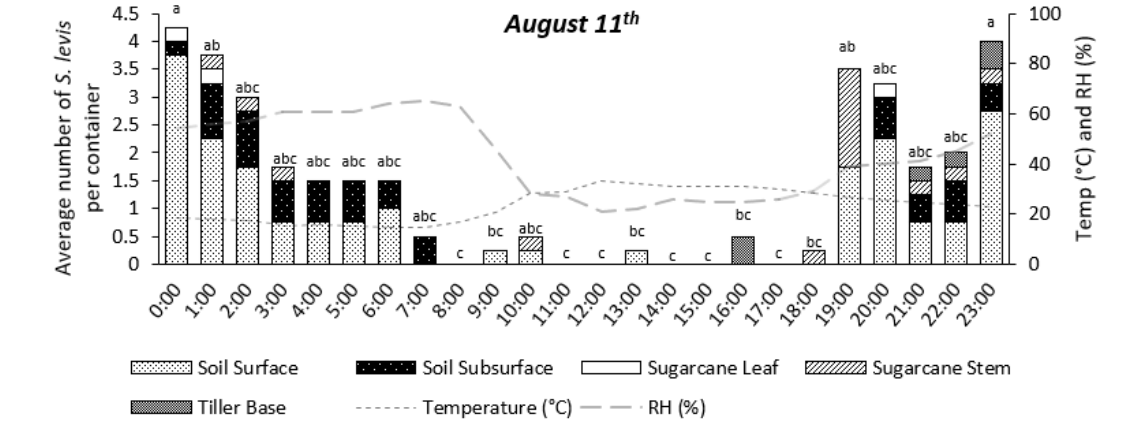
Figure 7. Number of visible S. levis adults per container at every hour on 11 August considering insect location, temperature (temp) and relative humidity (RH%). Bars with mean values followed by same letter are not different at α = 0.05.